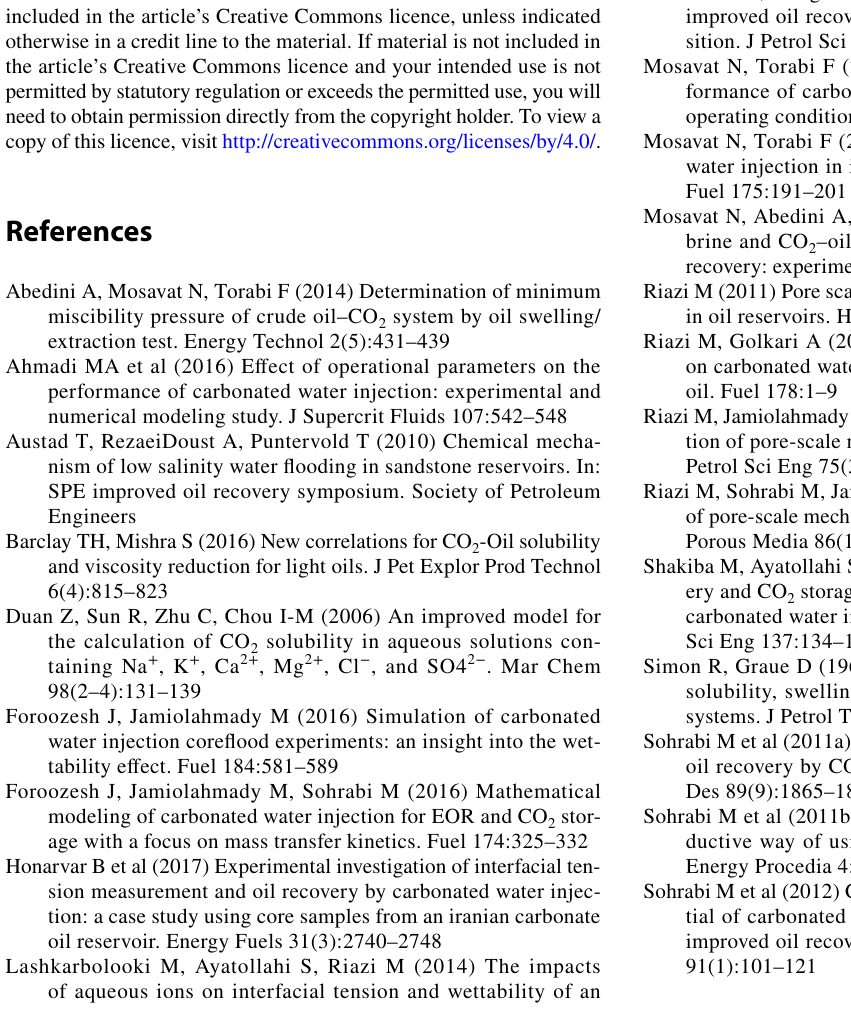
Fig. 10 Differences between solubility values of CO ence and absence of 15,000 ppm of Na 2 SO 4 and MgSO 4 at different temperature and pressure conditions obtained based on Duan model (Duan et al.